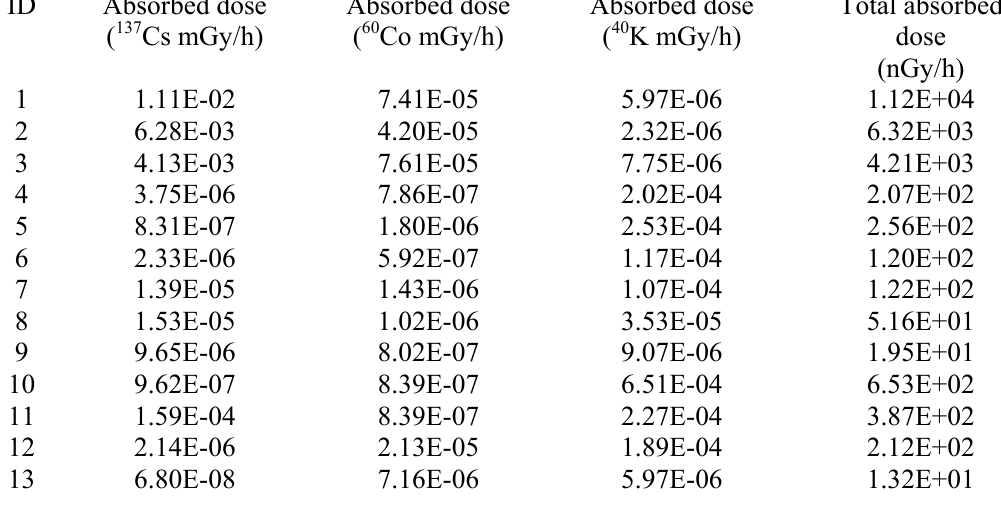
Table 3: The absorbed dose rate of 137 Cs, 60 Co and 40 K in the samples collected from a surface and above the